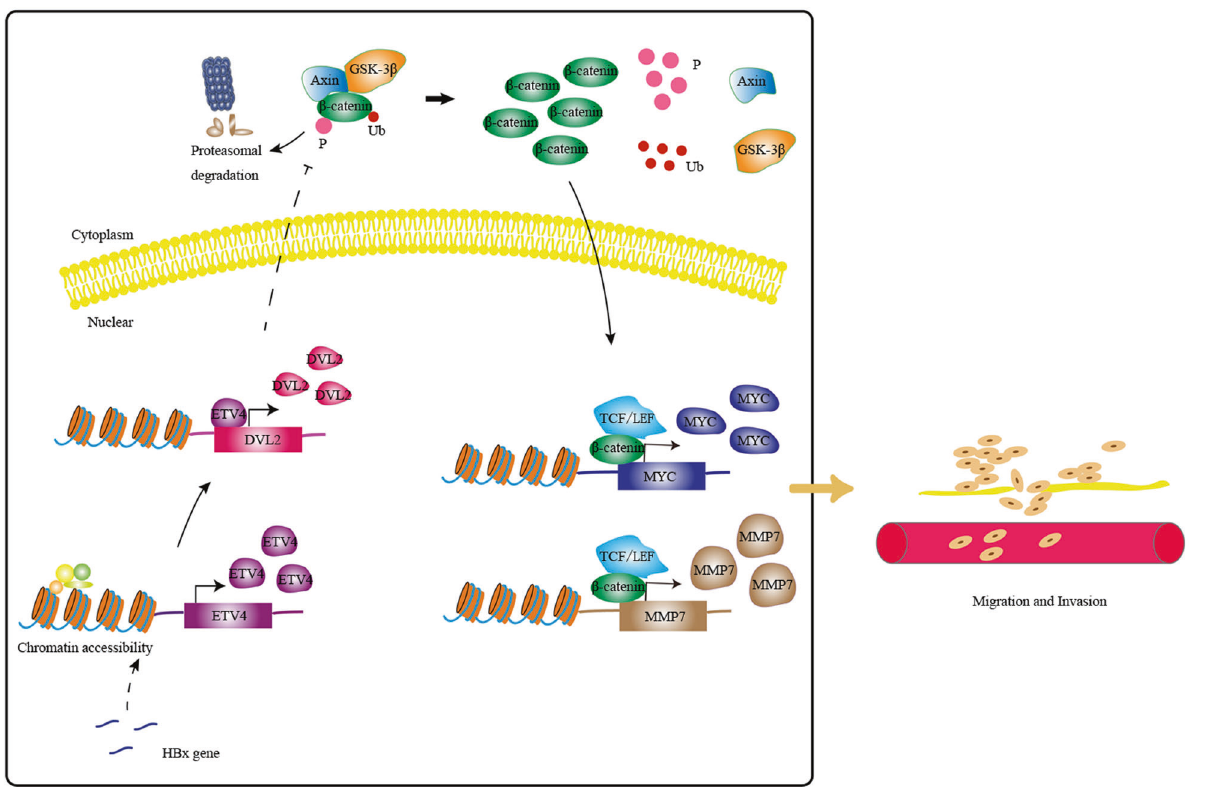
Fig. 7 A schematic diagram showing that the ETV4 functions in HCC metastasis. HBx induces the oncogenic effects of ETV4 in HCC by regulating DVL2 in transcriptional level, and then in fl uence the Wnt/ β -catenin signaling pathway to promote HCC metastasis and